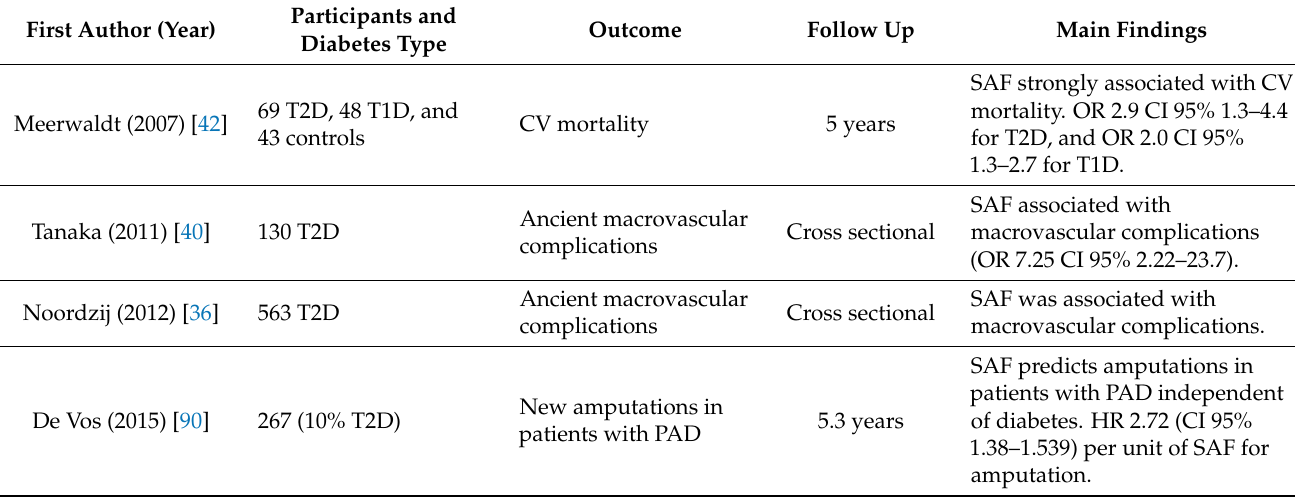
Table 2. SAF as a biomarker of cardiovascular